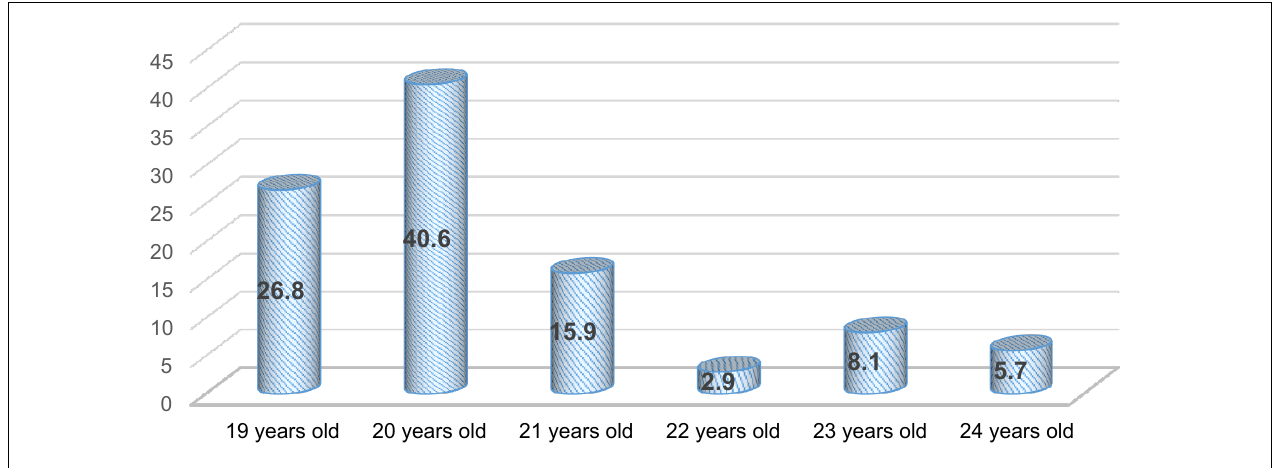
FIGURE 1 | Distribution of the participants according to age